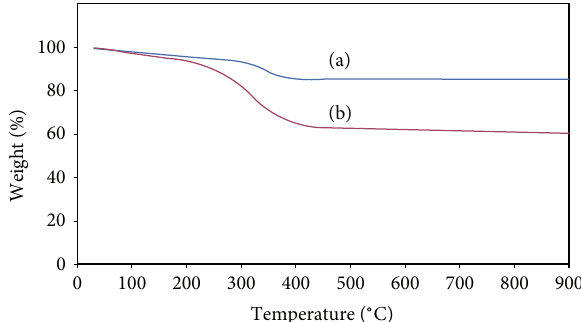
F 2: TGA curves for samples A and B of TNPs from room C ((a) and (b)). temperature to 900 ○